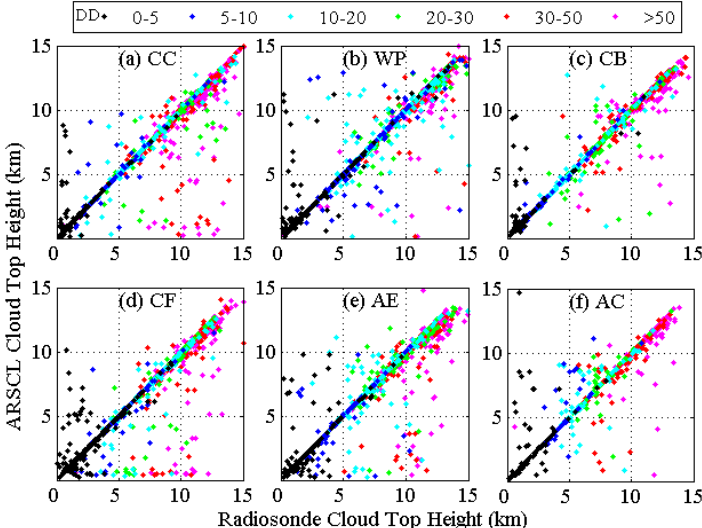
Figure 9. Comparison of collocated cloud-top heights derived from the radiosonde and ARSCL data in the synoptic patterns of: CC ( a ); WP ( b ); CB ( c ); CF ( d ); AE ( e ); and AC ( f ) during 2001–2010 at the SGP site. Colored dots in each panel represent different radiosonde drift distances (DD; units in km).